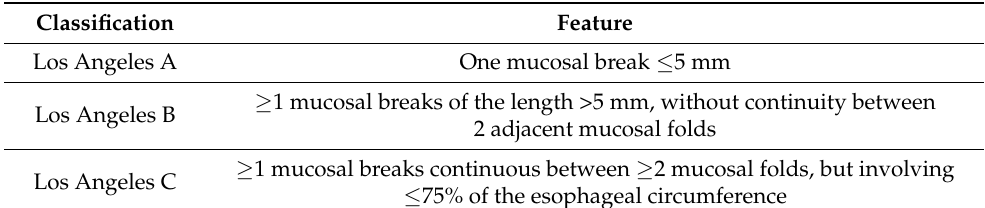
Table 3. Los Angeles